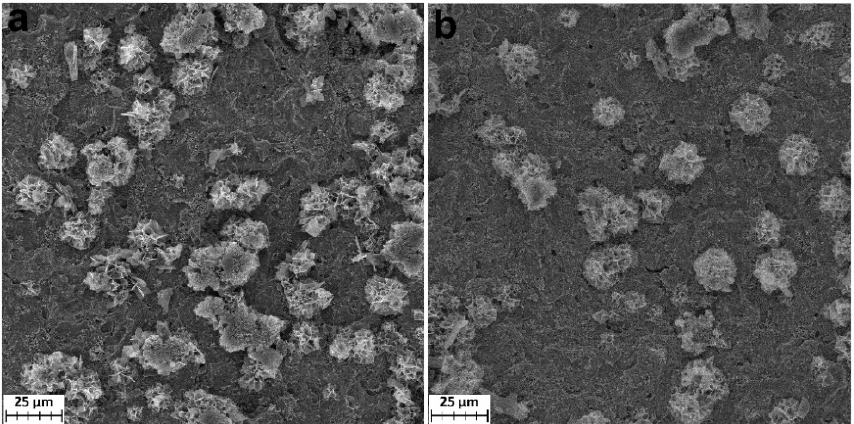
Figure 13. SEM images of the Ti-TiO 2 (TiCl 4 /H 2 O) ( a ) and Ti-TiO 2 (TTIP/H 2 O) ( b ) samples soaking in SBF for 10 days.